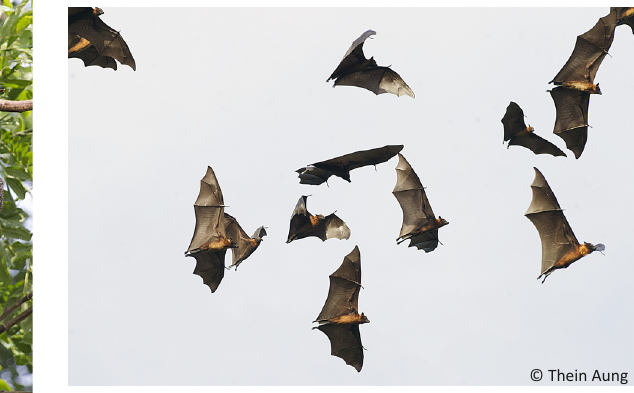
Image 1. Pteropus giganteus from Bagan Image 2. Pteropus giganteus from